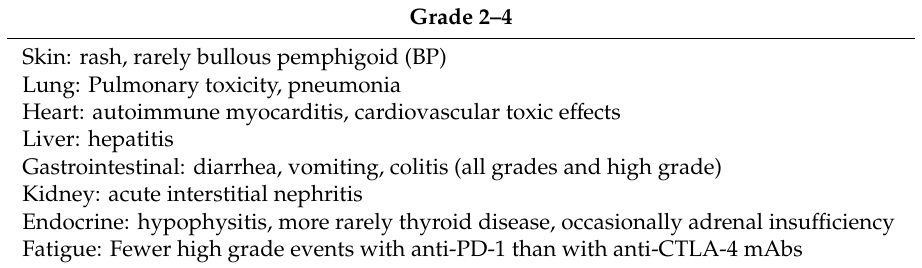
Table 4. Side e ff ects of immune checkpoint inhibiting mAbs: Immune-related adverse events (irAEs). Grade